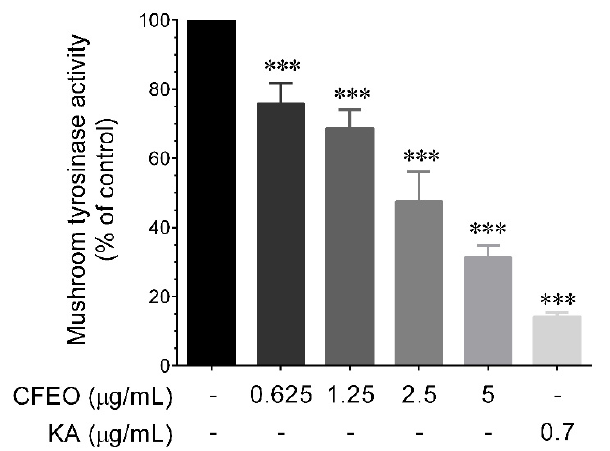
Figure 1 . Effect of CFEO on mushroom tyrosinase activity. The data are represented as mean ± SD of three indipendent experiments. Statistical significance was set as *** p < 0.001 compared with sample treatment groups vs. control group.